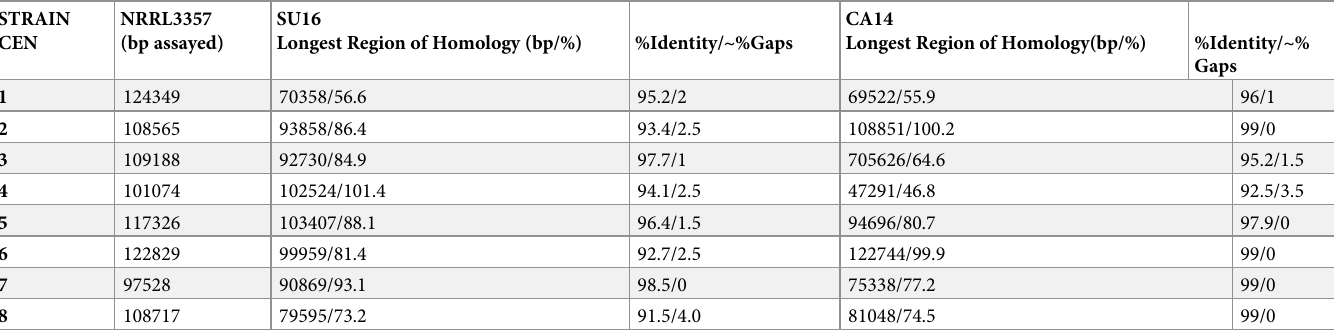
Table 5. Centromere sequences of homologs have strongly conserved regions.